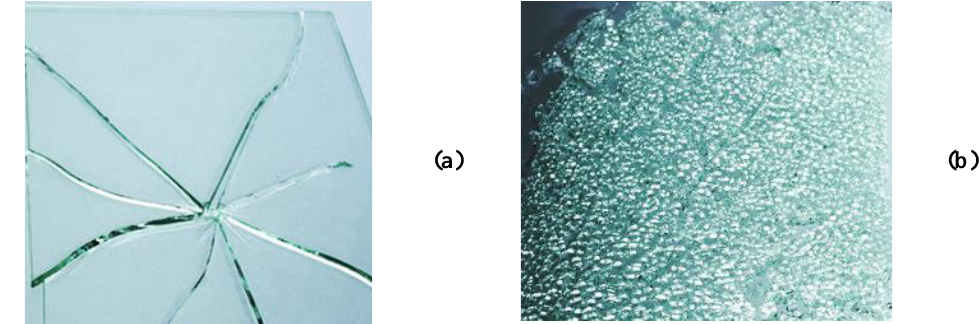
Fig. 1 Fracture (failure) behaviour of (a) annealed glass, (b) tempered